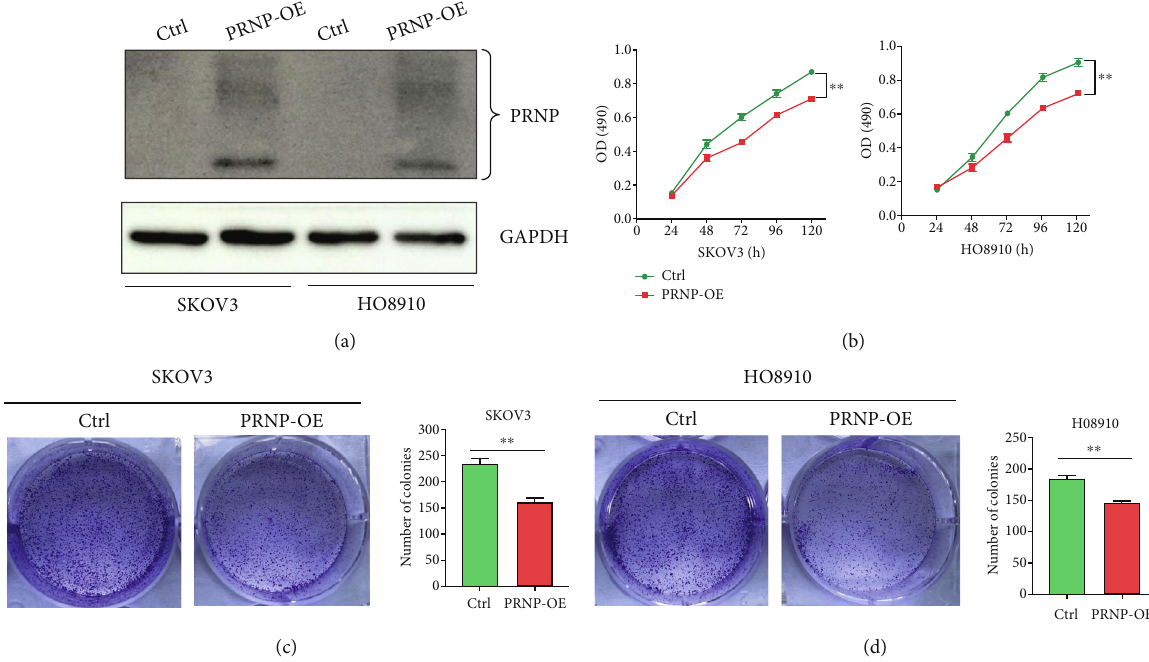
Figure 4: Overexpressed PRNP inhibited the proliferation of OC cell lines. (a) The expression of PRNP after PRNP overexpression plasmid treatment in two OC cell lines. (b) CCK8 assay when PRNP was overexpressed in two OC cell lines. (c and d) Colony formation assay when PRNP was overexpressed in two OC cell lines. OE: overexpression; ∗∗ p < 0 : 01 .